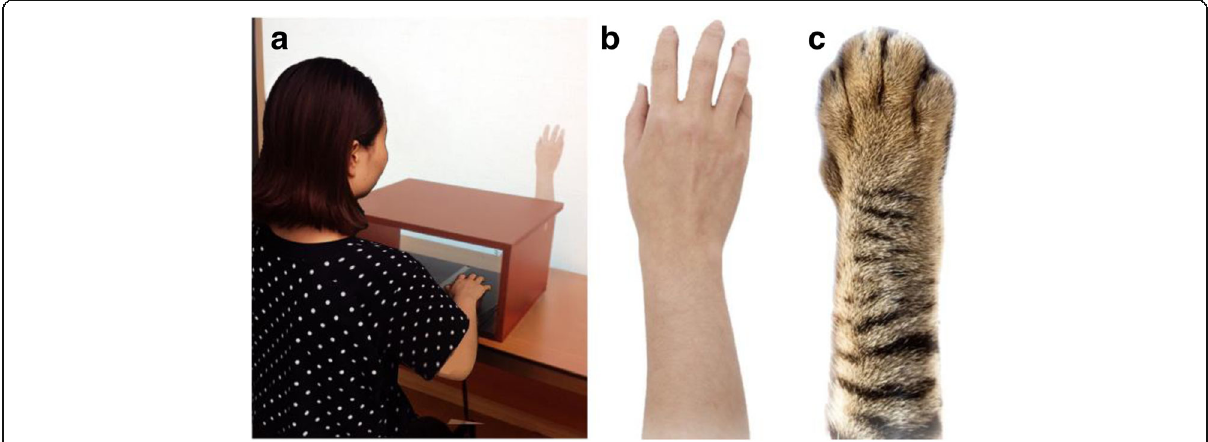
Fig. 1 Experiment and virtual images. a experimental facilities. b human hand. c cat's